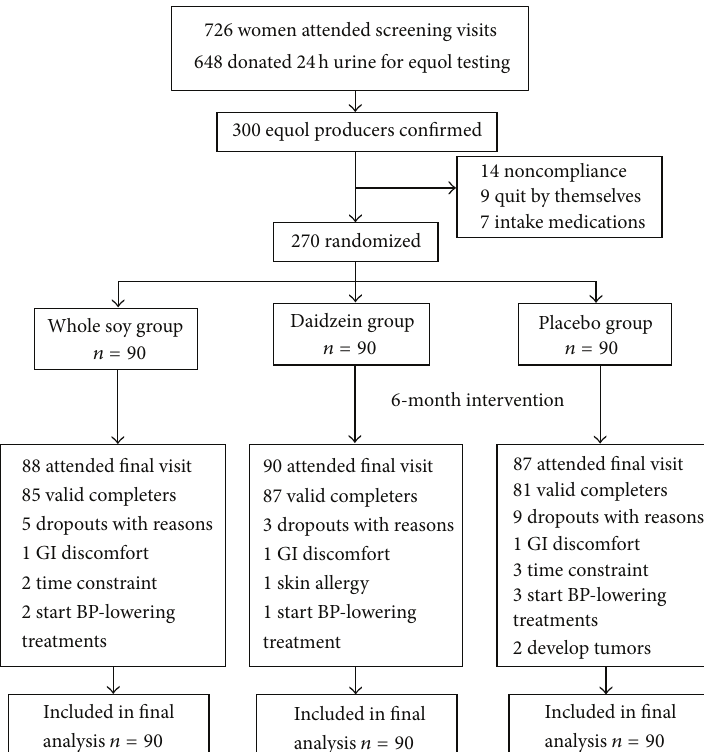
Figure 1: GI discomfort: gastrointestinal discomfort; BP: blood pressure; Whole soy group: intake 40g soy flour per day; Daidzein group: intake 63 mg daidzein + 40 g low-fat milk powder per day; Placebo group: intake 40g low-fat milk powder per